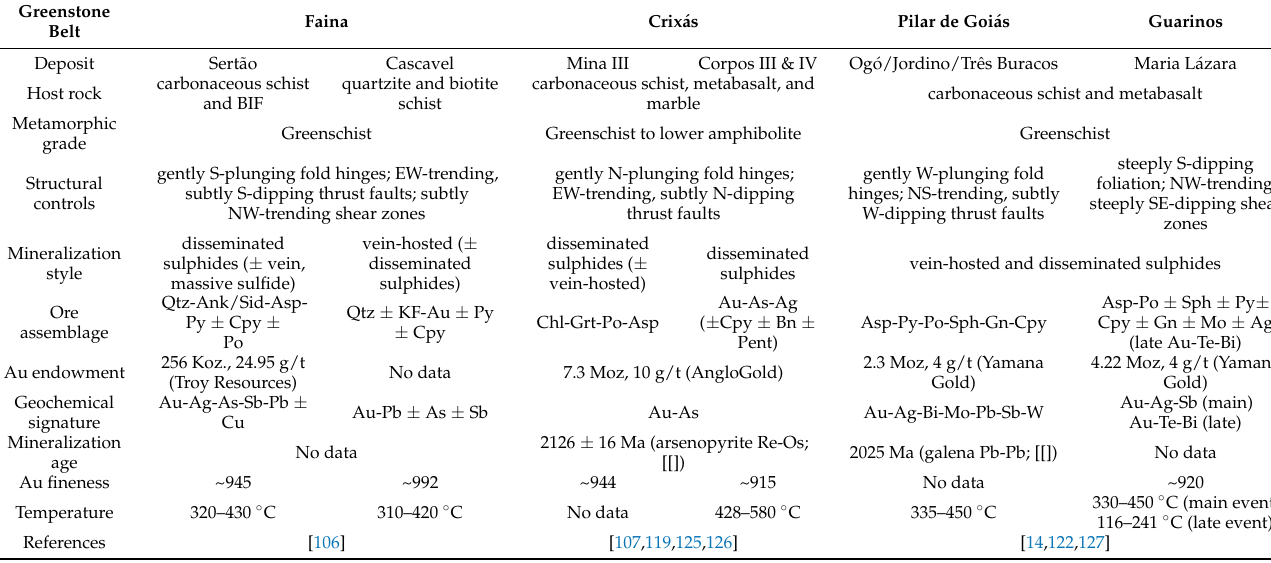
Table 5. Summary of characteristics of orogenic gold deposits in the